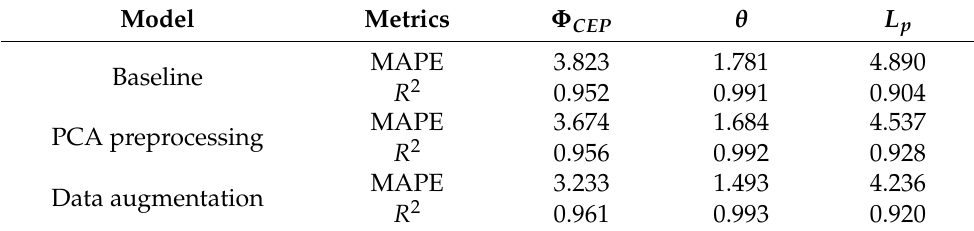
Table 1. Accuracy and coefficient of determination for the reconstruction of parameters of the laser–plasma interaction for the models trained on clean data.